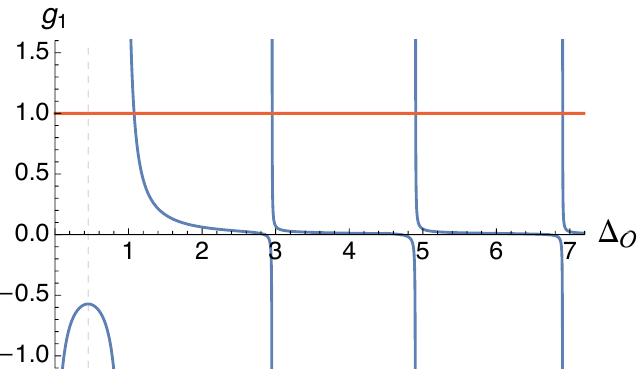
Figure 6 . Solution of eigenvalue problem g 1 (∆ O ) = 1 in d = 2 . 9 dimensions. The vertical dashed line corresponds to the unitarity